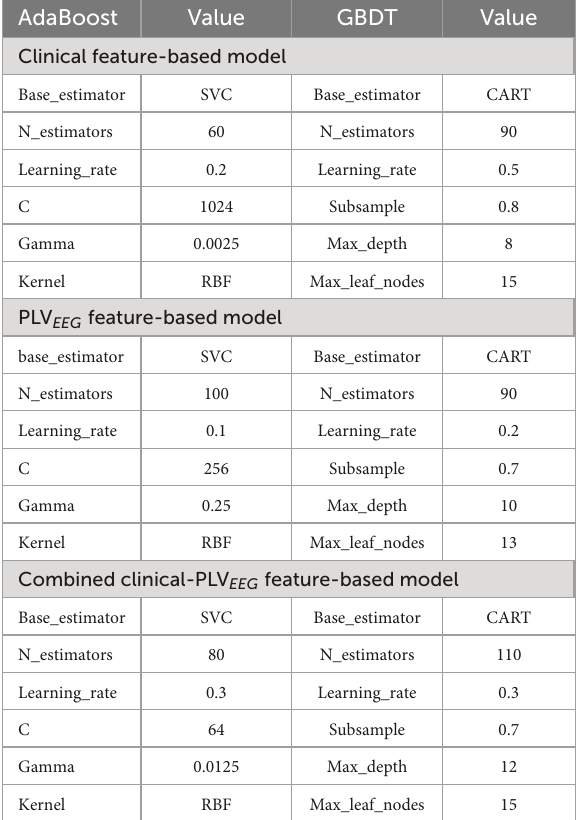
TABLE 3 The parameters of the